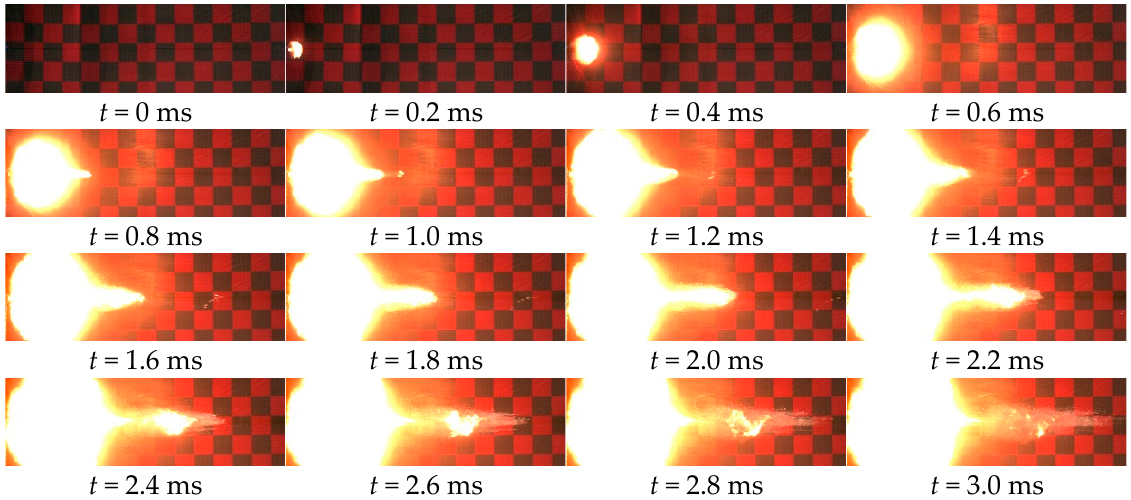
Figure 5. Flame evolution characteristics on the muzzle of the launching system.